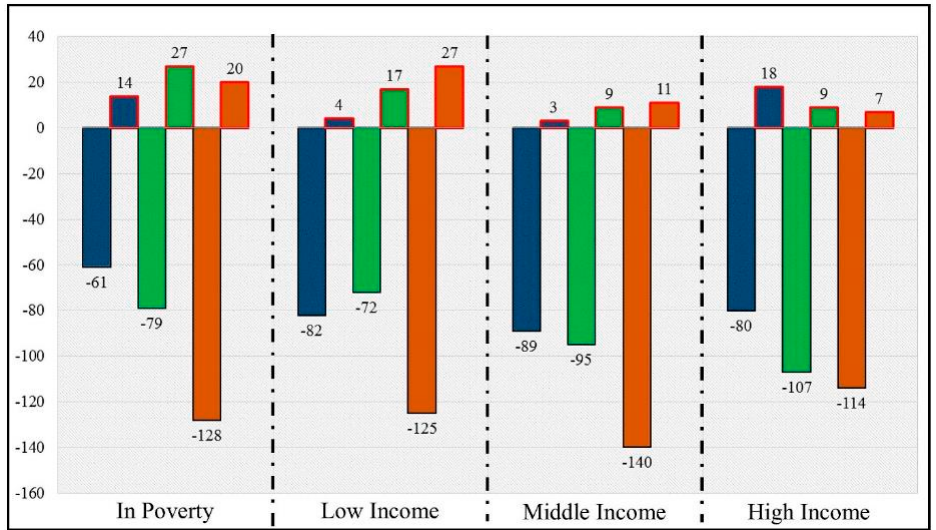
Figure 11. Comparison of the joint impact of the three scenarios on all income groups. It should be highlighted that the negative number shows the decrease in negative impacts (concepts) and positive numbers shows the increase in negative impacts. Legend: Blue bar represents the scenario: public health; green bar represents the scenario: water and electricity system; orange bar represents the scenario: transit system.